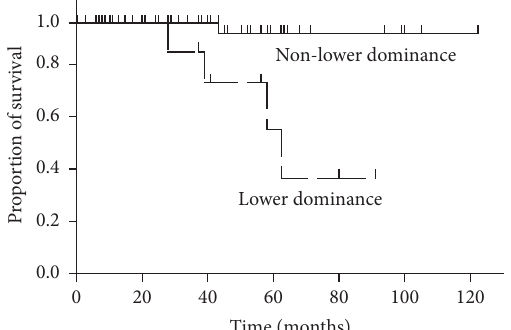
Figure 4: Comparison of overall survival between patients with lower dominance and nonlower dominance. Survival of patients was calculated from the date of frst evaluation with pulmonary sarcoidosis. Te lower dominant group (all: dashed line and except for the atypical cases: dotted lines) showed signifcantly worse survival rates than the nonlower dominant group (the solid line). p < 0 . 001 in the log-rank test. +: censored patients.